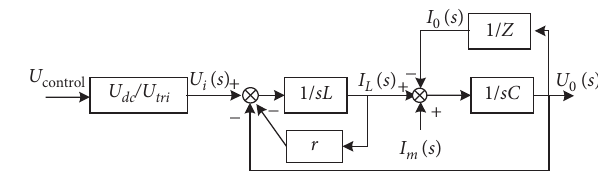
Figure 4: Equivalent dynamic model of the ESS in ESS-integrated PV/wind station.